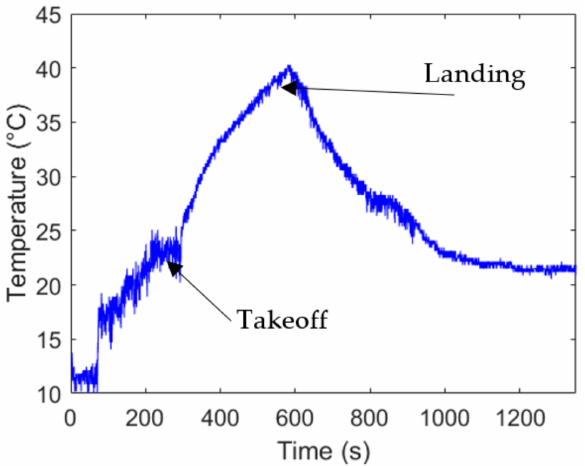
Figure 9. Thermocouple data inside fuselage.